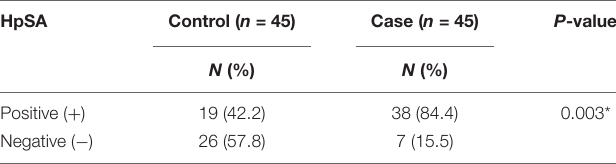
TABLE 3 | Distribution of H. pylori stool antigen (HpSA) among the two groups.